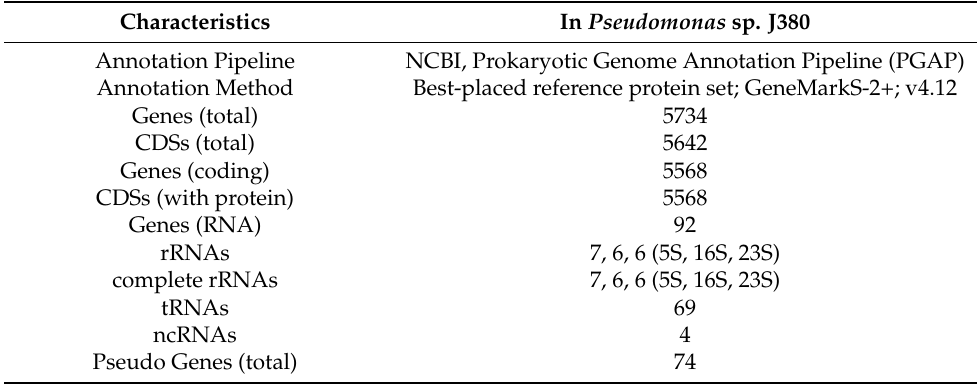
Figure 4. Genome map of Pseudomonas sp. strain J380. The genome map was generated using CGView Server. Different elements or features of the chromosome are illustrated by distinct colors as described in the legend. Table 2. Summary of Pseudomonas sp. J380